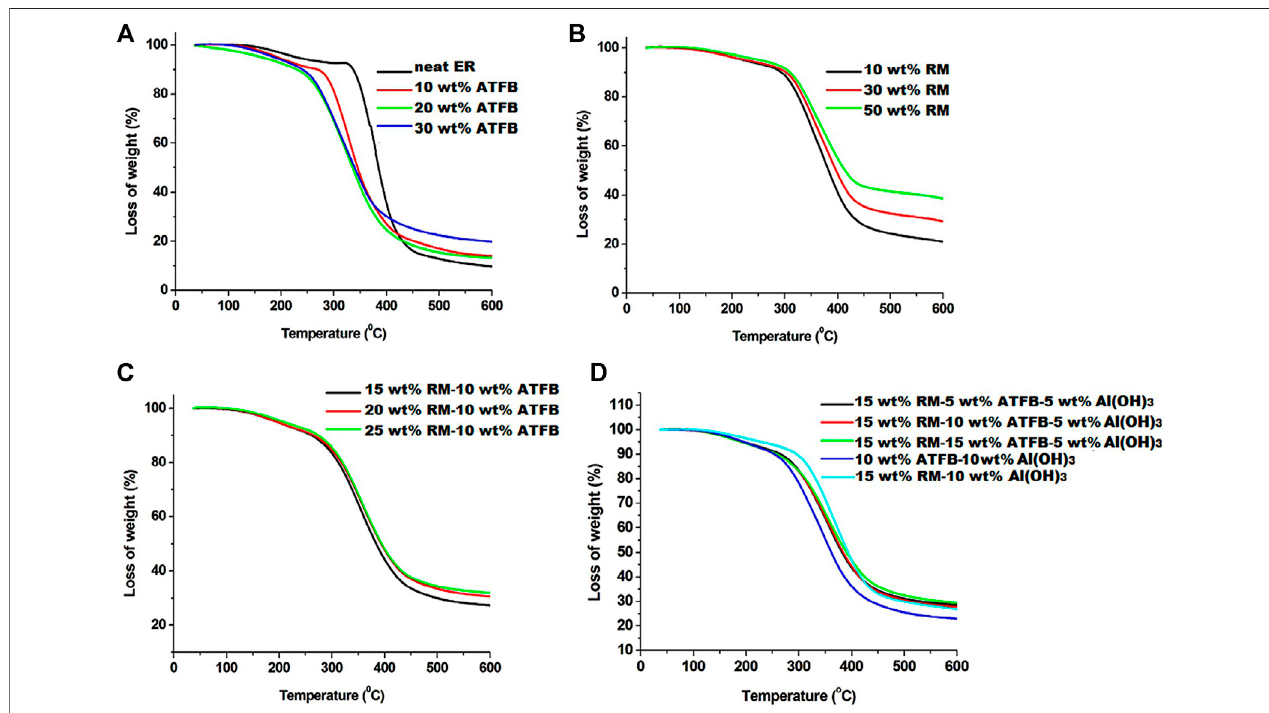
FIGURE 1 | Thermogravimetric analysis (TGA) curves of (A) the neat ER and ER composites with 10 – 30 wt% ATFB, (B) ER composites with 10 – 50 wt% RM, (C) ER composites with 15 – 25 wt% RM and 10 wt% ATFB, and (D) ER composites with different contents of RM, ATFB, and Al(OH) 3 (Kusakli et al., 2020).